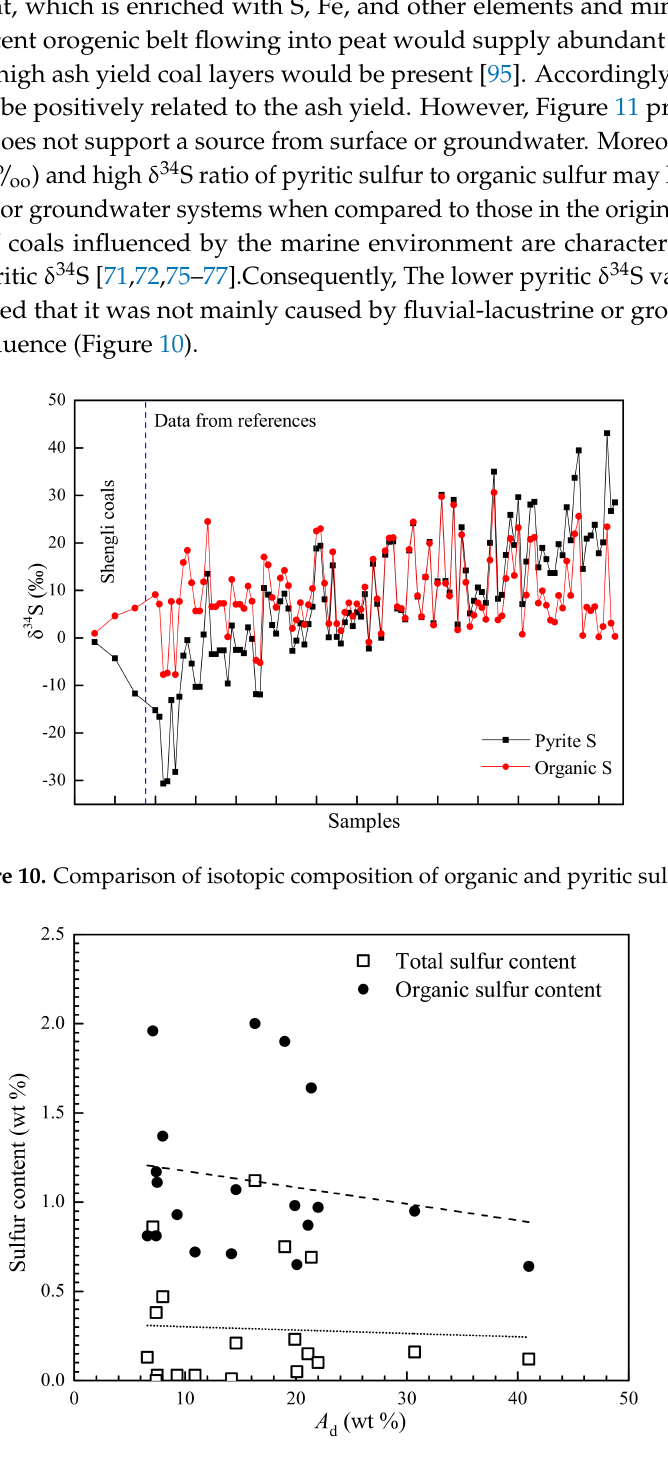
Figure 11. Relation between A d and sulfur